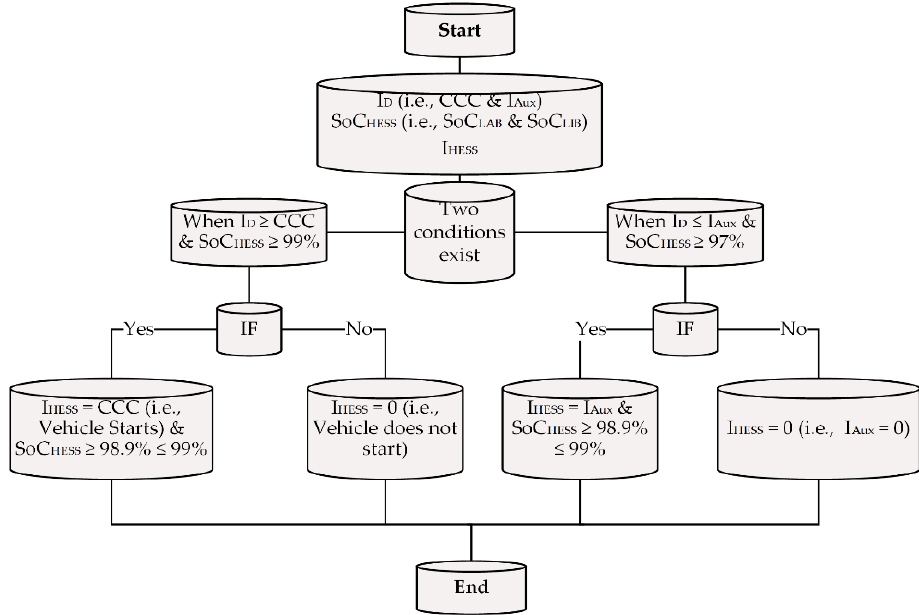
Figure 4. Logic flow chart of the proposed rule-based BMS for HESS during discharging mode operation, Reproduced from [37] .